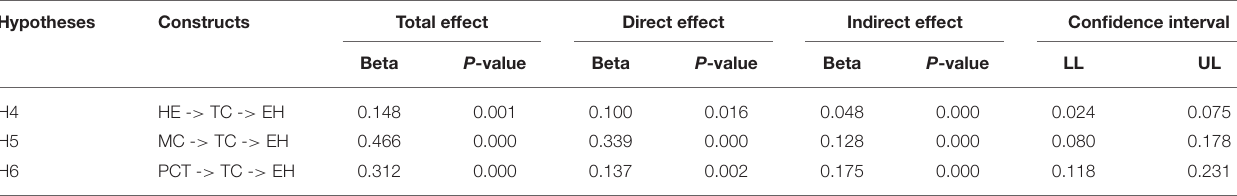
TABLE 8 | Indirect